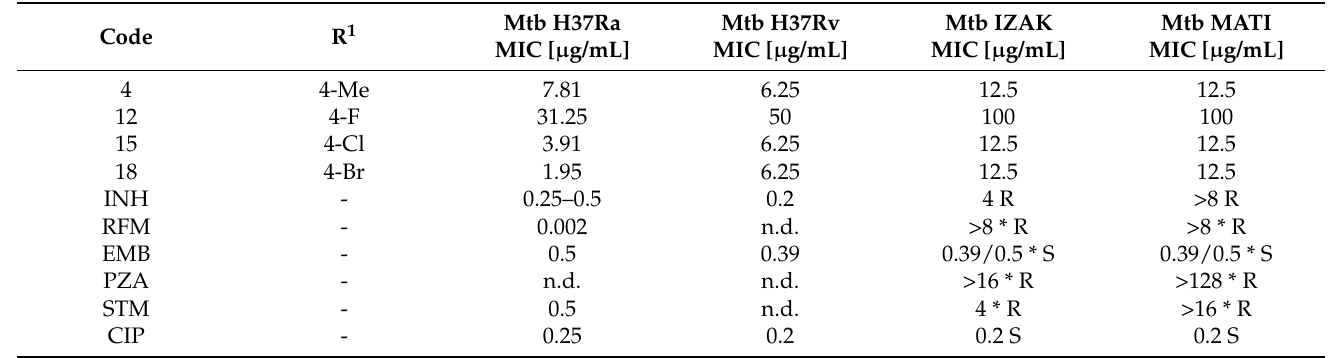
Table 5. Antimycobacterial evaluation of selected compounds on MDR clinical isolates (IZAK, MATI) in comparison with drug-sensitive strains H37Ra and